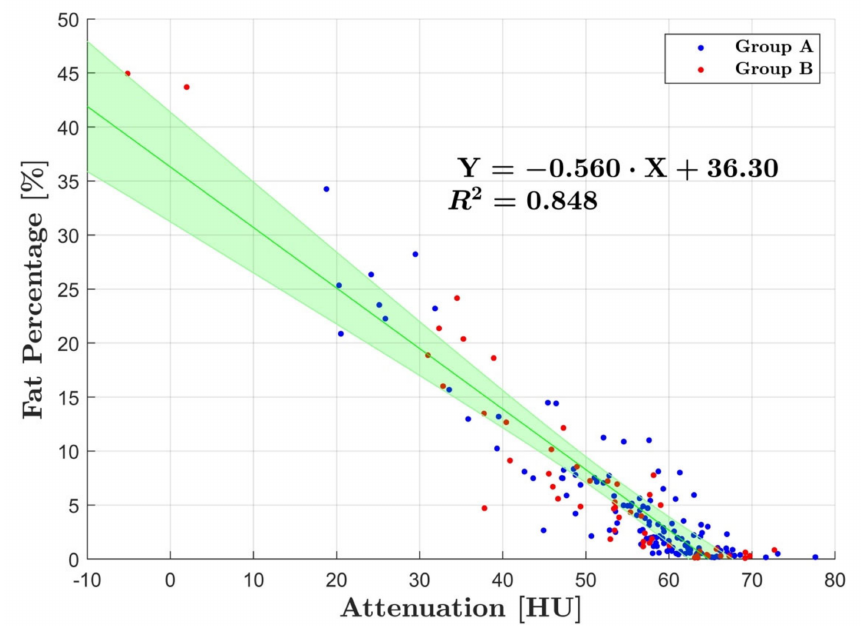
Figure 5. Linear regression analysis with group A and B combined. There was a strong correlation between fat percentage and HU with R 2 = 0.85. The blue dots represent the average measurements for group A and the red for group B. The green line corresponds to line for best fit and the shaded area represents the 95%